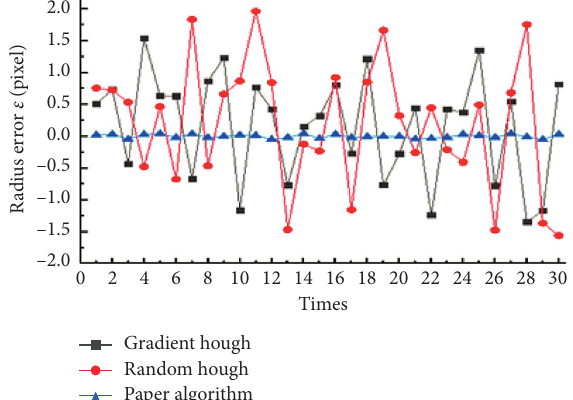
Figure 12: The error curve of the compensation hole radius of the 30 times brake master